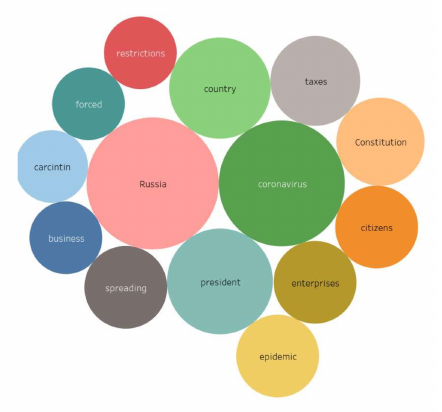
Figure 10. Associative network for stimulus state (10/2,510), Moscow actors).